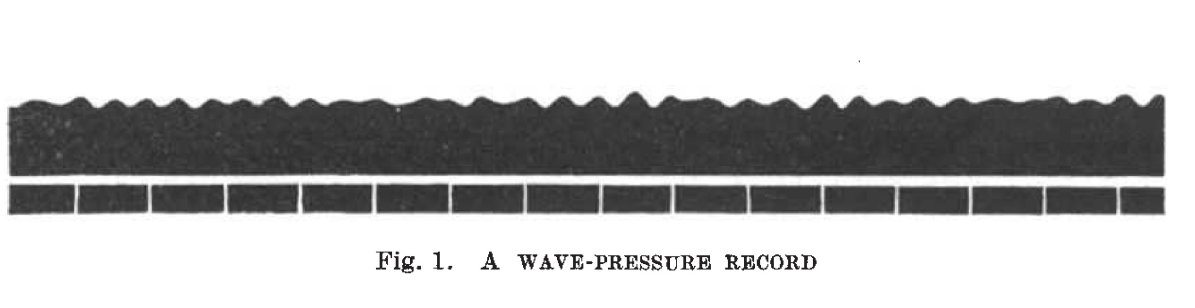
Figure 7: Figure 1 from N. F. Barber, F. Ursell, J. Darbyshire, and M. J. Tucker. 1946. “A Frequency Analyser Used in the Study of Ocean Waves.” Nature 158: